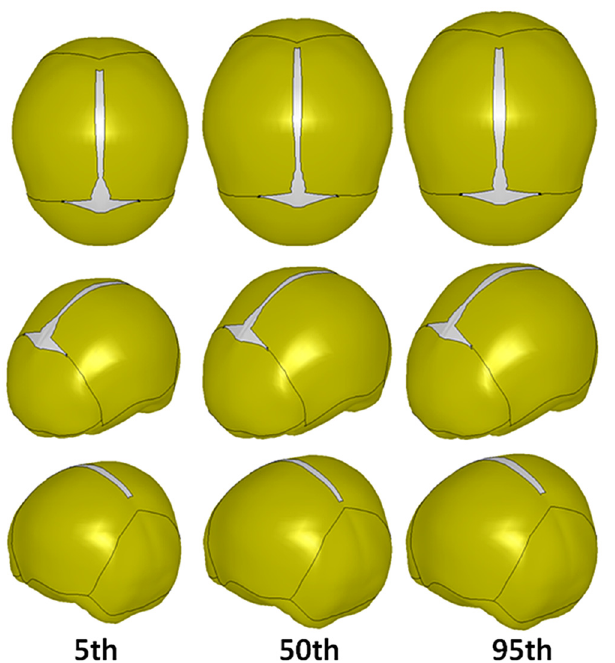
Fig 7. Head size/shape and suture variation among 1.5 YO